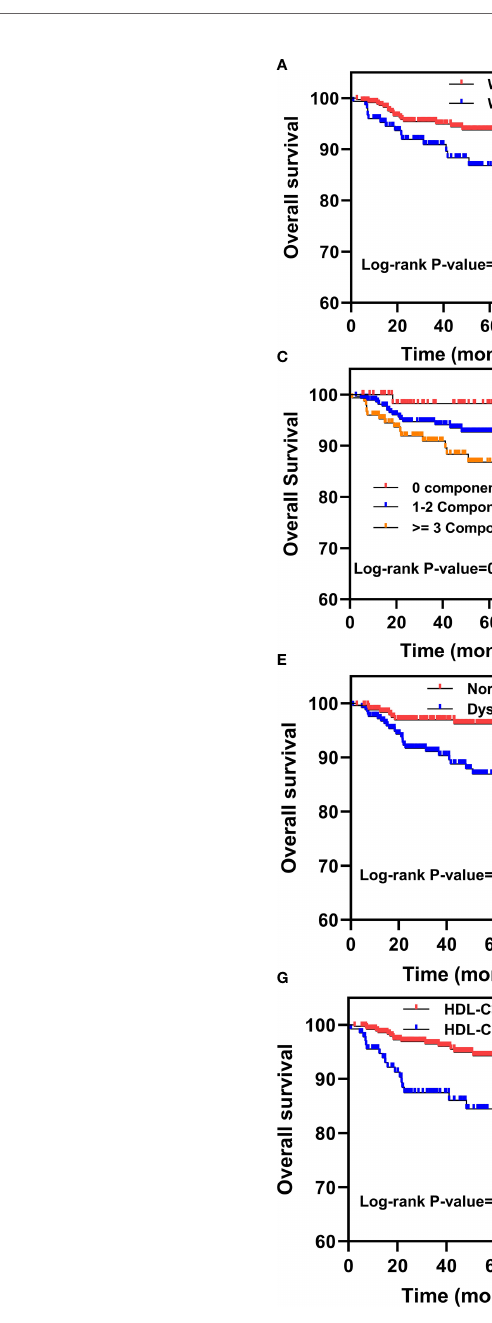
FIGURE 1 | Kaplan – Meier analysis for overall survival (OS) and recurrence-free survival (RFS) in EC patients with MetS and its components. (A, B) The Kaplan – Meier survival analysis of the OS and RFS between EC patients with or without MetS. (C, D) Kaplan – Meier survival analysis of the OS and RFS between EC patients with 0 components, 1 – 2 components or ≥ 3 components. (E, F) The Kaplan – Meier survival analysis of the OS and RFS between EC patients with normolipidemia and dyslipidemia. (G, H) The Kaplan – Meier survival analysis of the OS and RFS between EC patients with HDL-C ≥ 1.0mmol/l and HDL-C